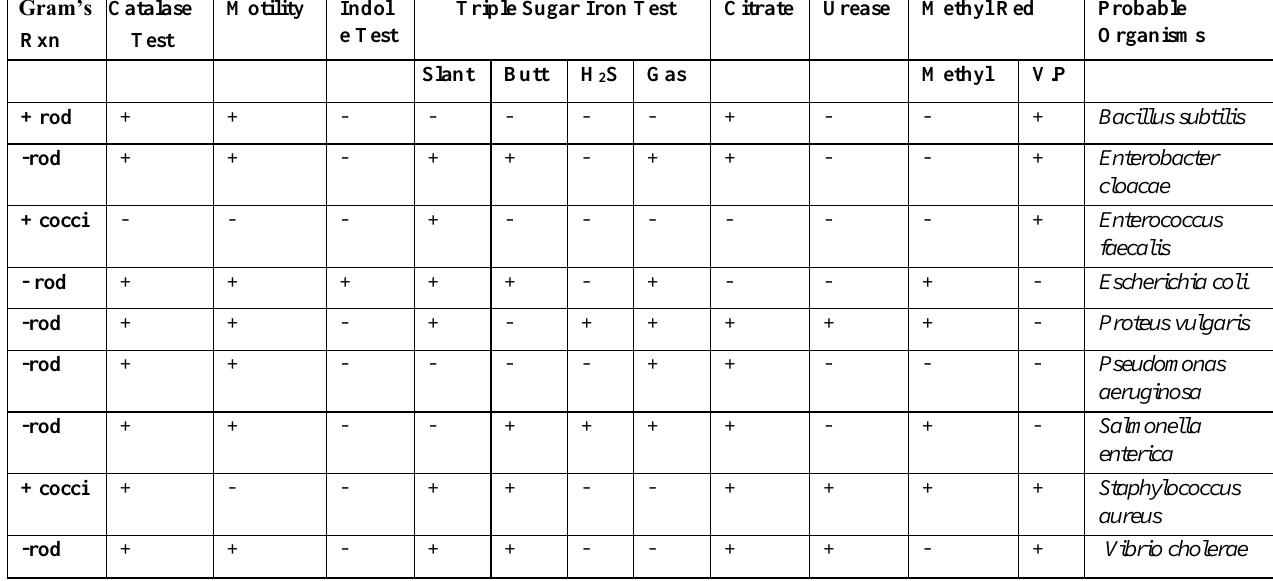
Table 1. Biochemical characteristics of bacteria isolated from seafood samples